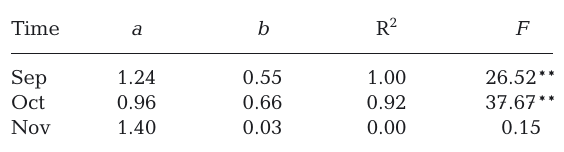
significantly lower than concentrations found in the experimental traps (Fig. 3), which indicated that the biodeposition of bay scallop may in fact be contri - buting to the enrichment of these substances in the sediment.